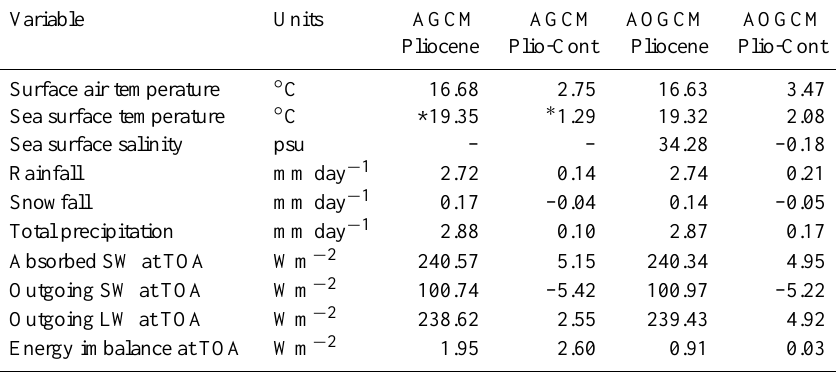
Table 4. Global mean annual values of surface air temperature, sea surface temperature, sea surface salinity, total precipitation, rainfall, snowfall and radiation fluxes at the top of the atmosphere (TOA). The differences between the mid-Pliocene and control runs are given in columns 4 and